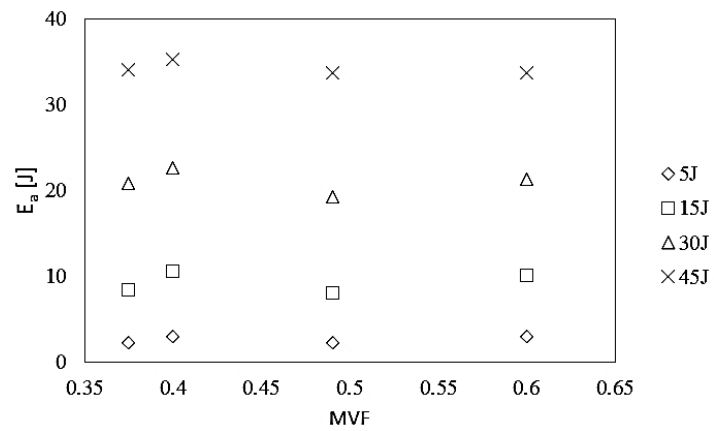
Figure 6. Absorbed energy vs. metal volume fraction in HTCL for various impact energies.